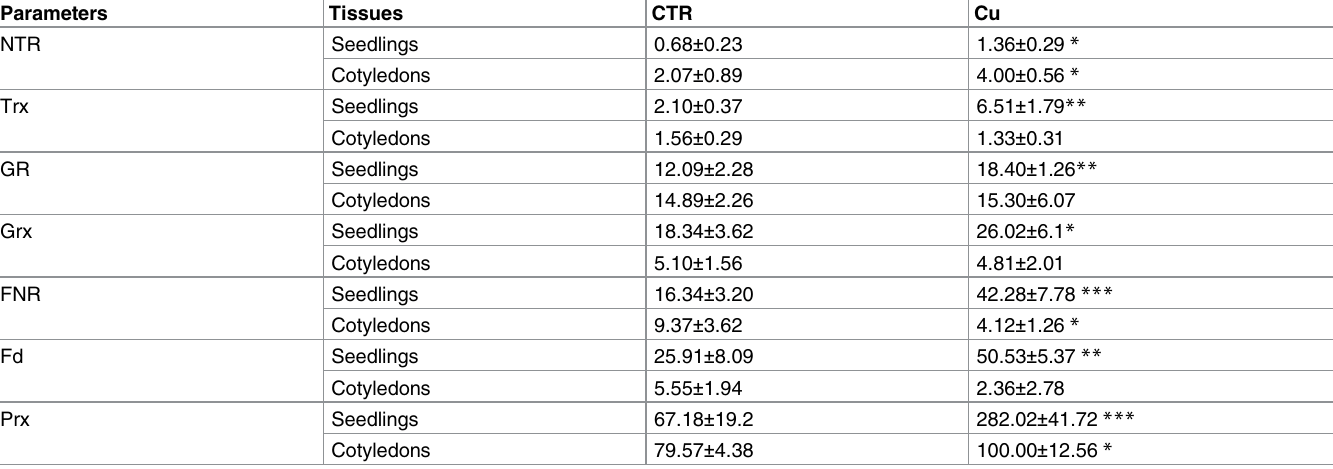
Table 3. Activities of redox enzymesin the seedlings (3 days-old) and the cotyledons (9 days-old) of germinated bean seeds in the presenceof H 2 O (CTR) or 200 μ M